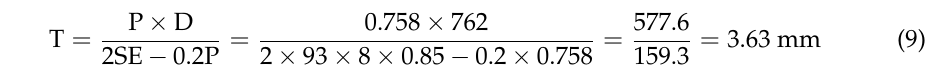
Figure 10. The upper side of the Dome ( A ), the Lower side of the Dome ( B ).